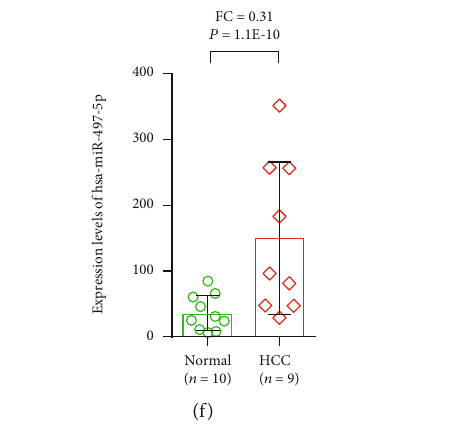
Figure 4: The levels of miR-497-5p expression in HCC samples. (a) The top ten DEGs miRNAs were screened out using MEV4.7.1 software. miR-497-5p (b), miR-139-5p (c), and miR-139-3p (d) were also highly expressed in tumor tissues compared with normal tissue. (e) The top twenty DEGs were selected between HCC and control samples. (f) The expression level of miR-497-5p was signi fi cantly higher in HCC tissue compared with nontumor